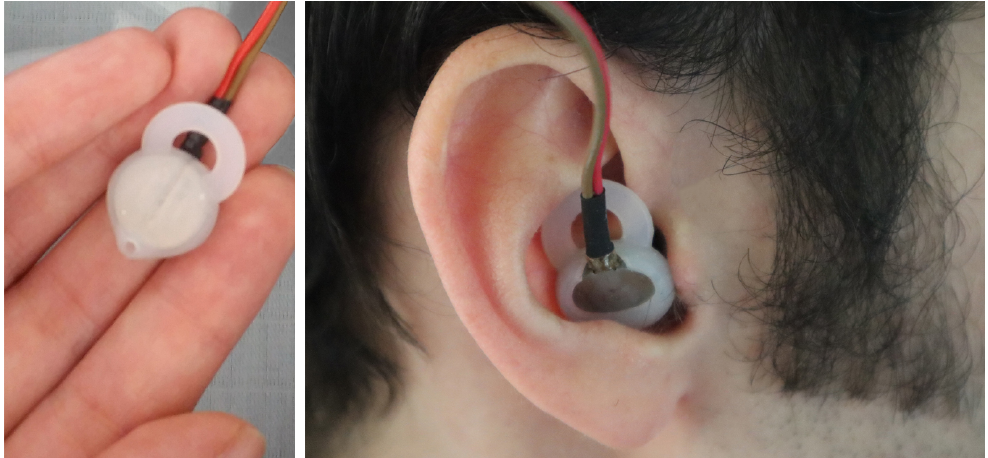
Figure 11. Mounting vibro-motors with soft covers inside users’